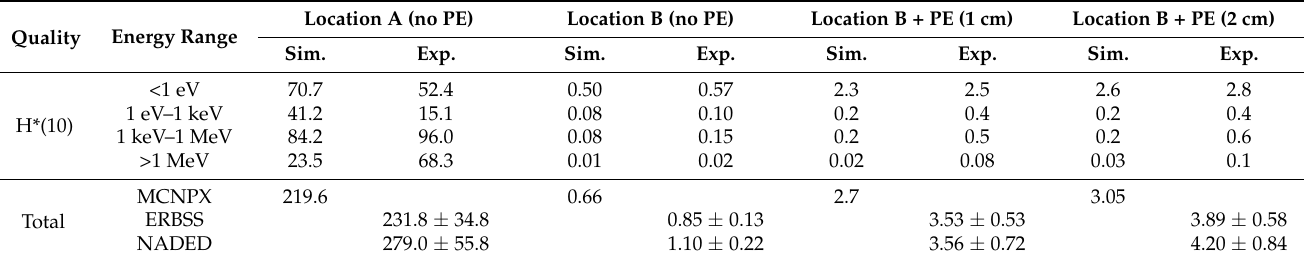
Table 2. H*(10) values for different energy ranges obtained from simulated and experimental spectra from ERBSS, and total ambient dose equivalent rate ( µ Sv/h @ 80kW) from simulations and